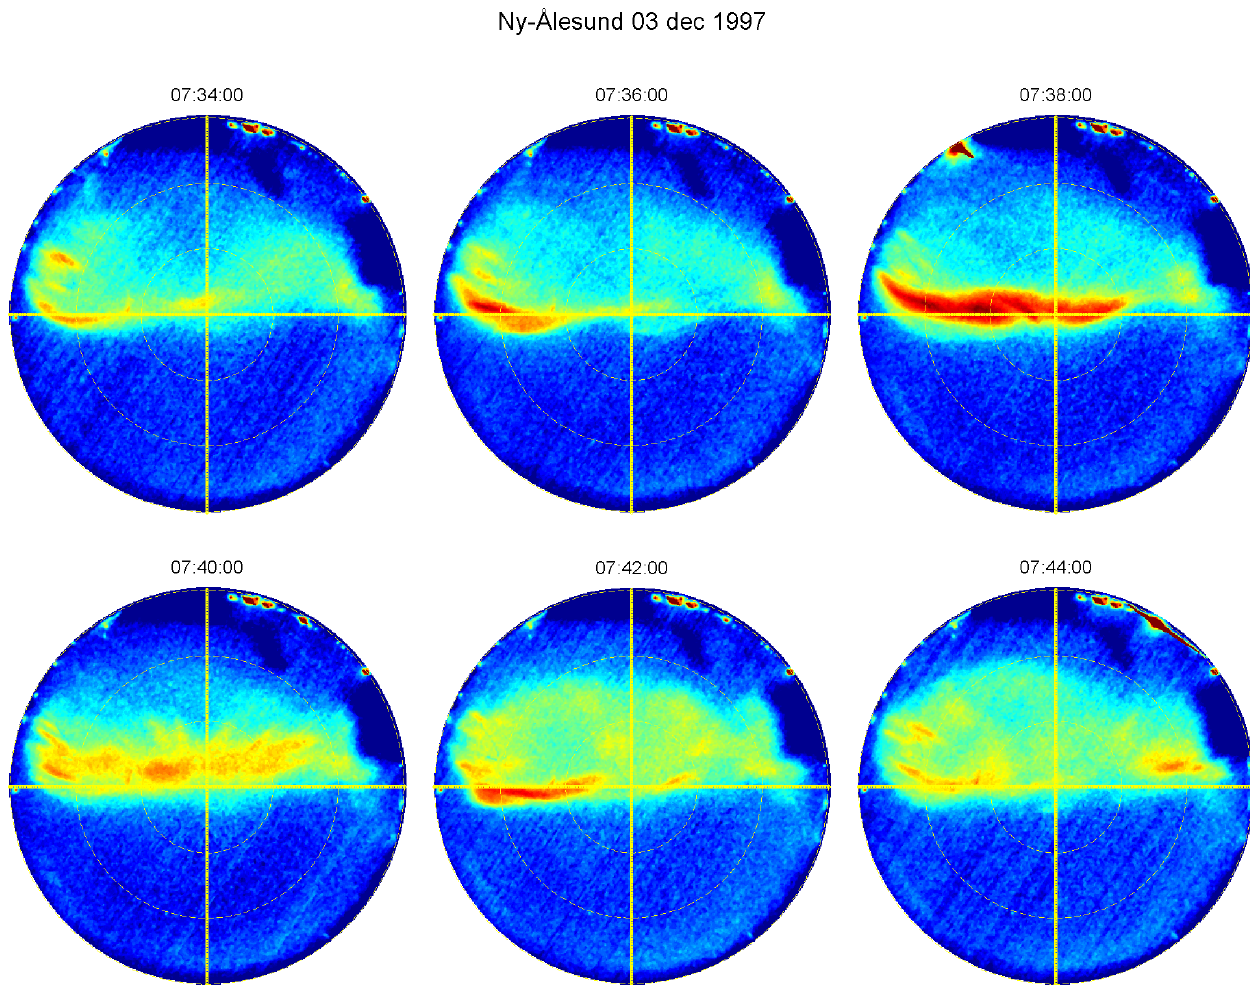
Fig. 5. ASC image sequence at 630.0nm during the interval 07:34–07:44UT. The coordinate system is zenth angle versus local azimuth. Zenith angles of 30, 60 and 90 ◦ are marked by dashed circles of increasing radius. The central vertical line marks the 11:00MLT meridian. North is up and west is to the left. The image integration time is